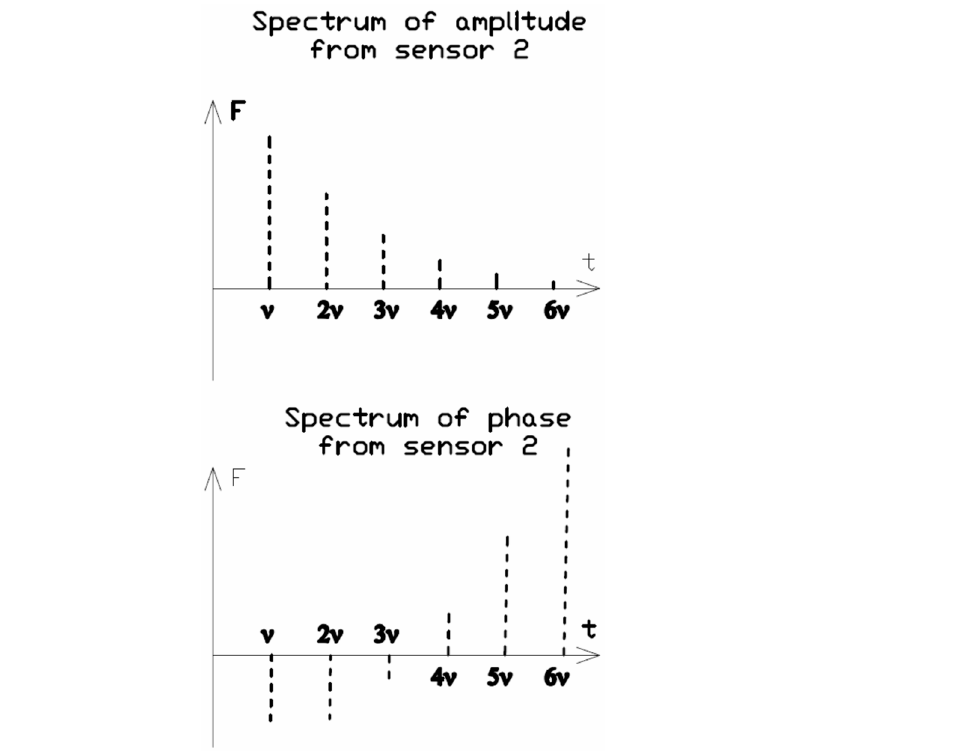
Figure 5. Amplitude and phase spectrum of the second sensor.